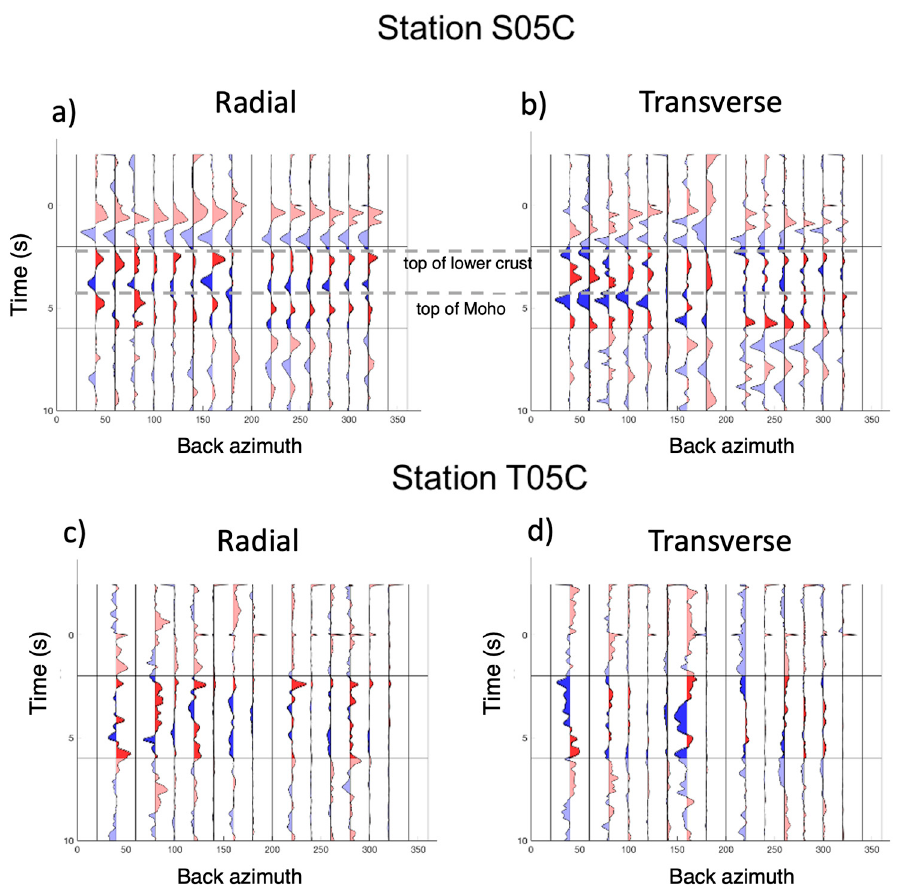
Figure 5. Comparison of data from two stations in the Central Valley, California where the S05C station has a clear signal, yet the T05C station does not. ( a , b ) radial and transverse data from the S05C station. ( c , d ) radial and transverse data from the T05C station. The horizontal black, solid lines indicate the four second Ps window, and the horizontal dashed gray lines represent the interpretation of the top of the lower crust and the Moho. For every station, the qualitative assessment was similarly straightforward.